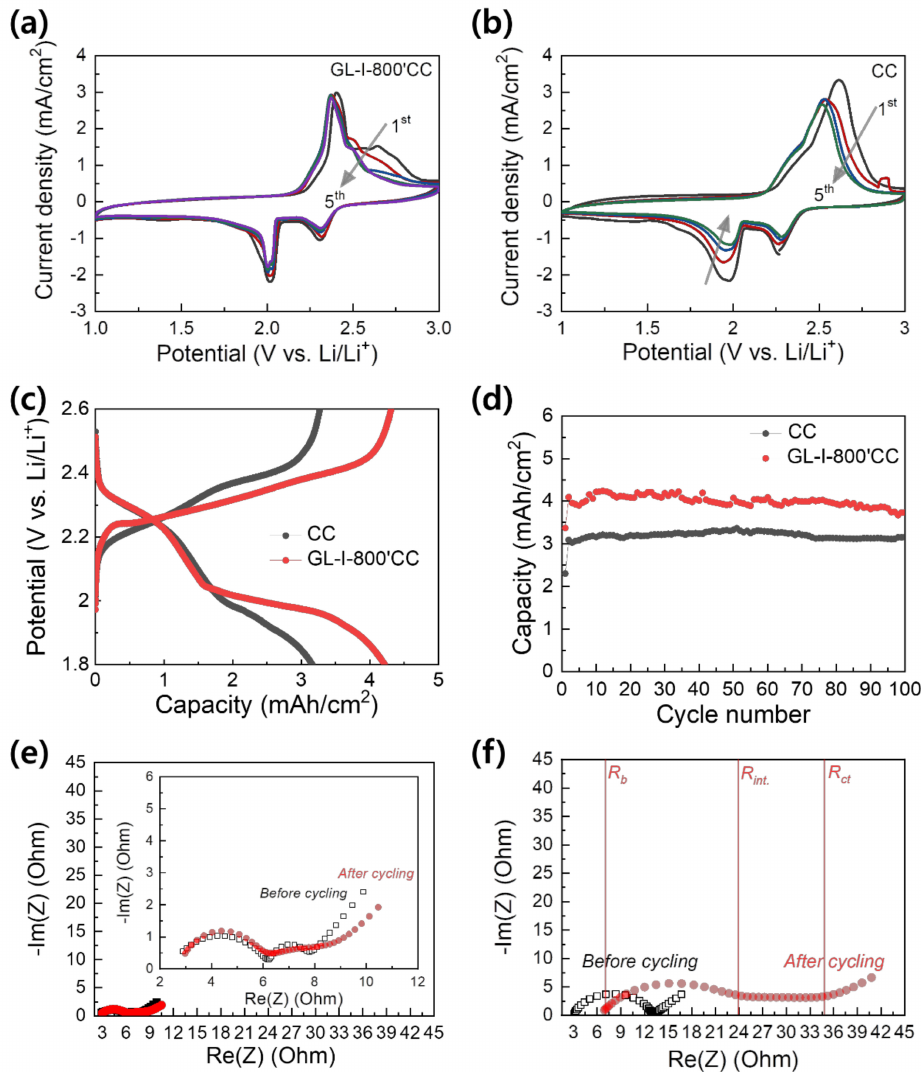
Figure 5. Cyclic voltammetry (CV) diagram of ( a ) Gl-I-800 (cid:48) CC and ( b ) CC. ( c ) The second galvanostatic cycling with potential limitation (GCPL) profile at 500 mA / g. ( d ) Capacity vs. cycle number at 500 mA / g. Electrochemical impedance spectra (EIS) of ( e ) GL-I-800 (cid:48) CC and ( f )